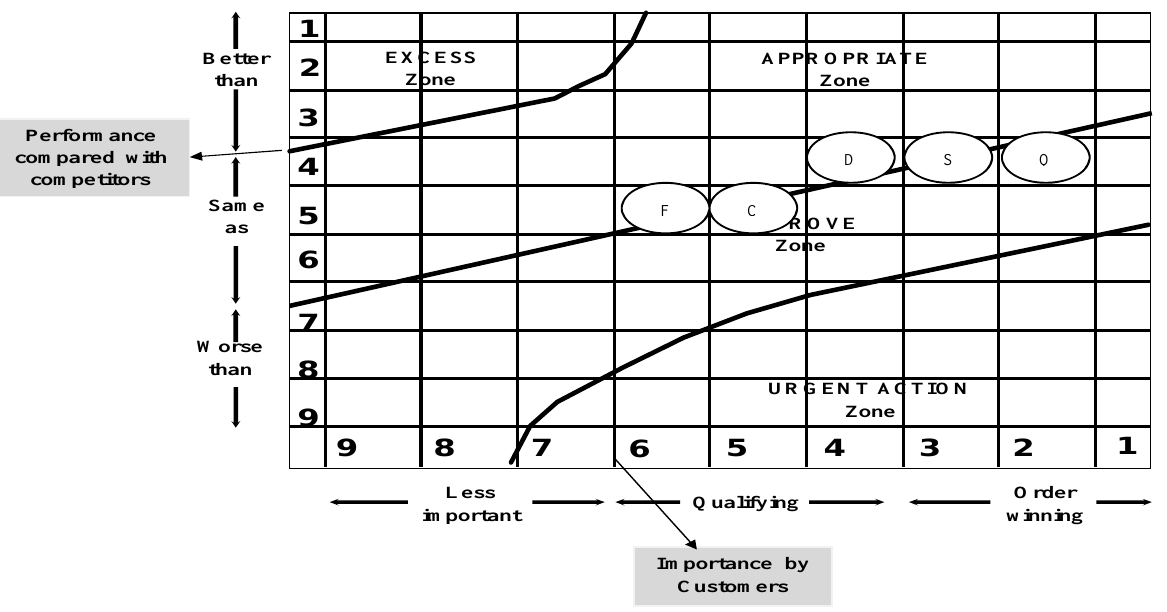
Fig. 3. The Importance-Performance Matrix of firm